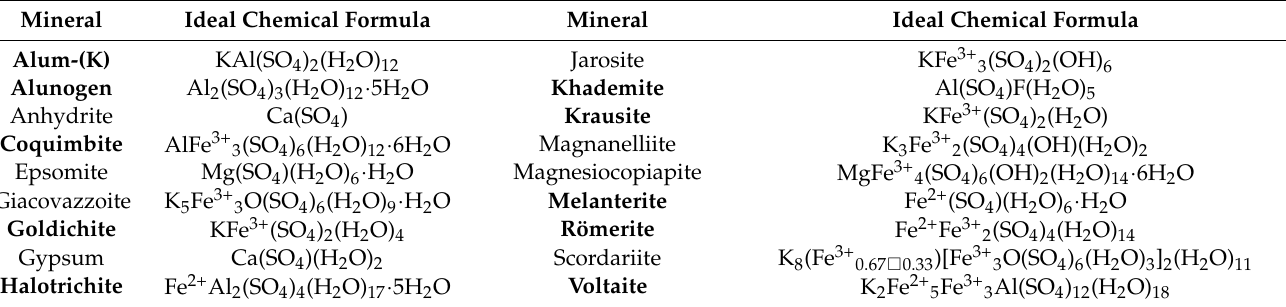
Table 1. Secondary sulfate minerals from the Monte Arsiccio